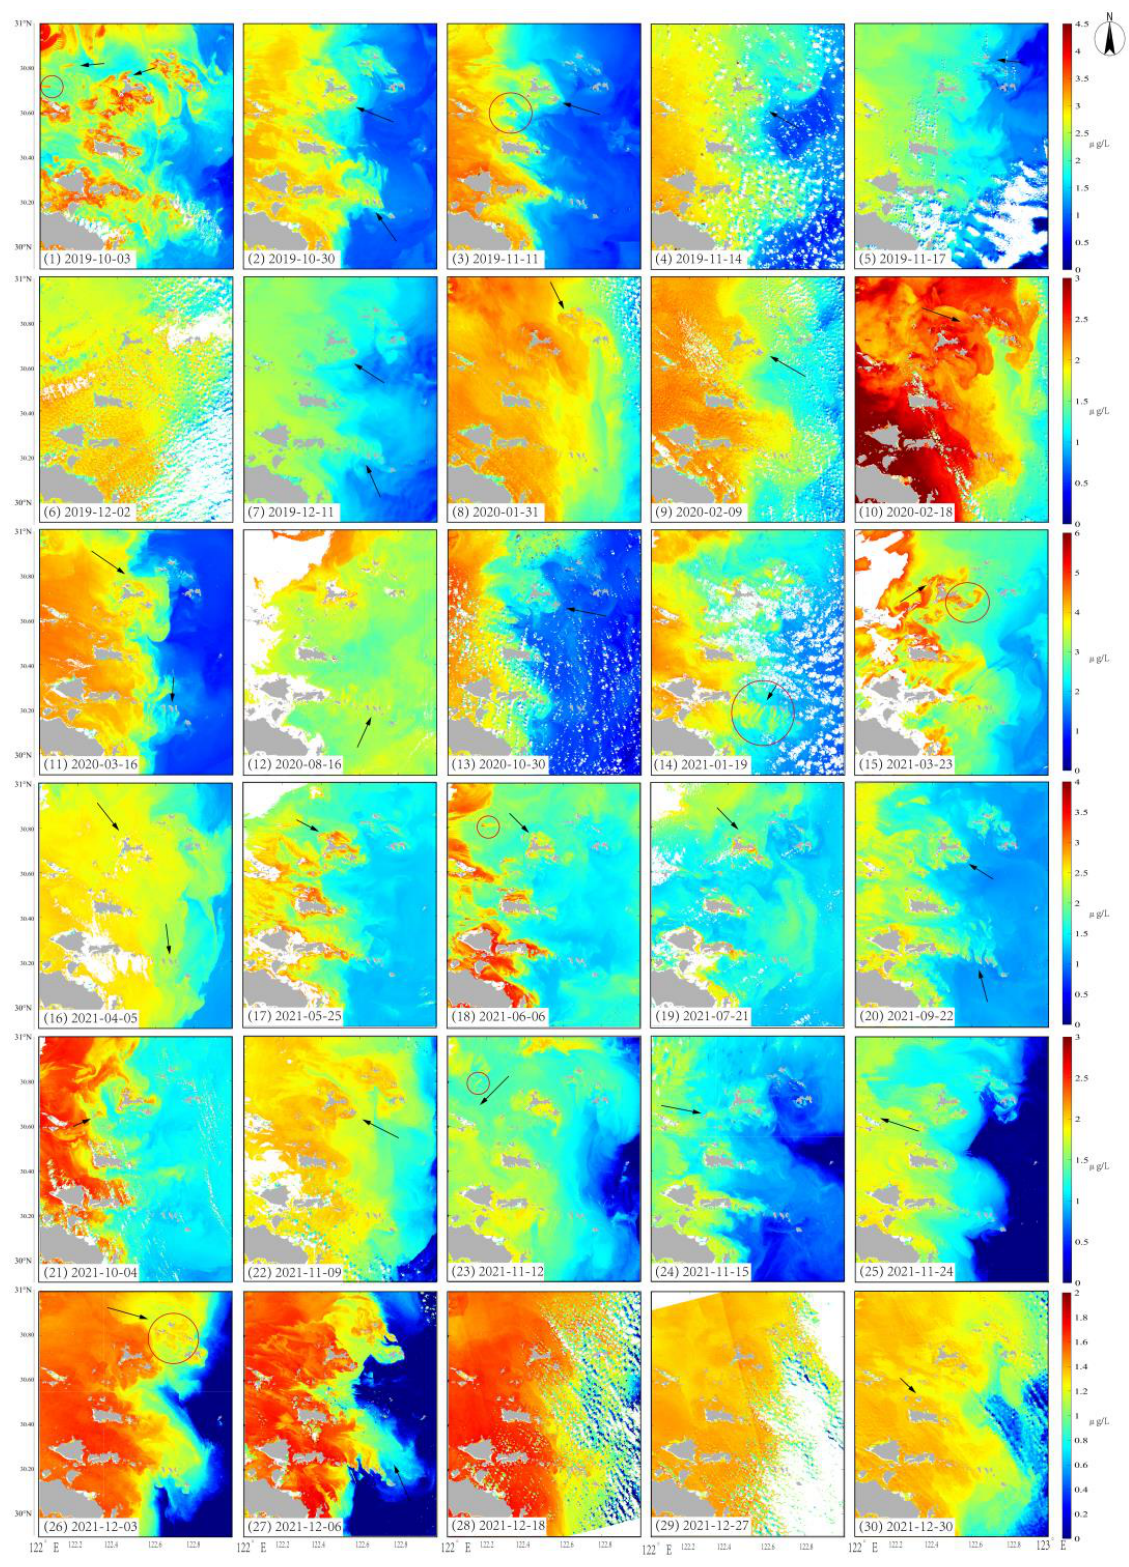
Figure 5. The distribution of Chl-a in the waters of Zhoushan archipelago from 2019 to 2021. ( 1 – 15 ): Chl-a retrieved from CZI loaded in HY-1C. ( 16 – 30 ): Chl-a retrieved from CZI loaded in HY-1 D. Black arrow: the direction of the local currents. Red circles: the obvious wakes induced by islands.